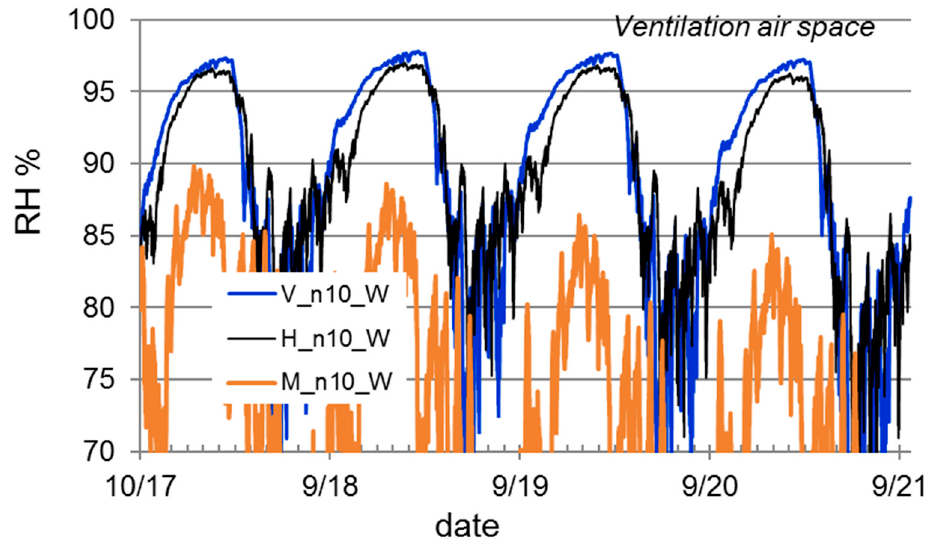
Figure17. Concretesandwichwall, wetexteriorcore, ventilationscheme1, n = 101 / h. Thesolvedrelative Figure 17. Concrete sandwich wall, wet exterior core, ventilation scheme 1, n = 10 1/h. The solved humidity in the ventilation air space in three di ff erent climates during the four-year simulation period. relative humidity in the ventilation air space in three different climates during the four-year simulation period.